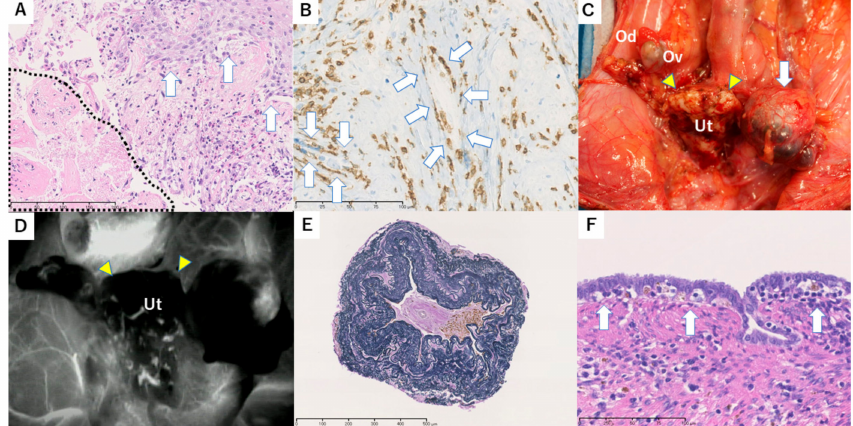
Figure 2. Macroscopic and histopathological findings in case 1. ( A ) Histopathological findings of a biopsy specimen from the uterine cervix on postoperative day (POD) 70. Severe stromal inflammation and capillary endotheliitis including lymphocytes and eosinophils were observed. Lymphocytes also infiltrated into squamous epithelium and resulted in liquefaction degeneration (white arrow). Necrotic change was also seen on the left side (within dotted line). These findings suggest severe rejection. Hematoxylin and eosin (H&E) stain, 200 × bar = 200 µ m. ( B ) Histopathological findings of a biopsy specimen from the uterine body in second-look surgery on POD 133. In the necrotic and hyalinizing areas of the uterus, CD8-rich lymphocyte infiltration is seen. The white arrow shows a capillary vessel with an endothelium detached by attack of CD8 T-cells. CD8 IHC (immunohistochemistry), 400 × bar = 100 µ m. ( C ) Macroscopic findings in the pelvis in autopsy on POD 196. A pale uterus Ov, Ovary; Od, Oviduct. ( D ) Intraoperative indocyanine green (ICG) fluorescence imaging of the